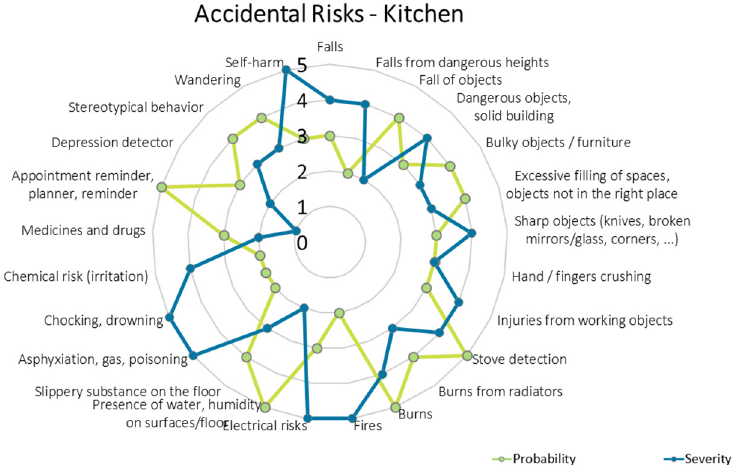
Figure 5. Probability and severity in the kitchen of a typical living environment: Accidental Risks.